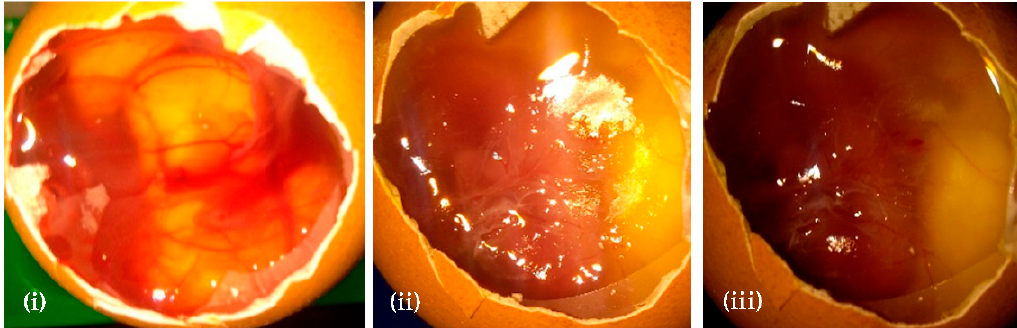
Figure 6. HET–CAM assay. ( i ) NaOH (0.1 M) Positive control—Indicates Blood hemorrhage; ( ii ) Negative control—Non- irritant Distilled water; ( iii ) (1 mg/mL) Test sample—non-irritant.